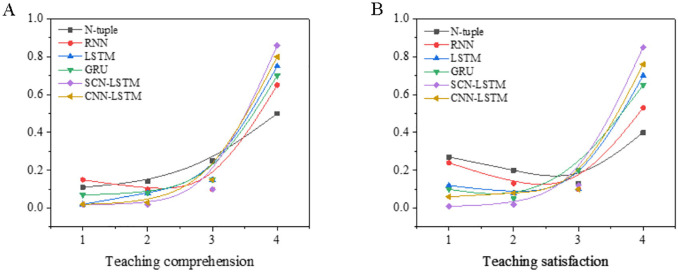
Evaluation of machine translation model of neural network based on residual and LSTM in teaching application.